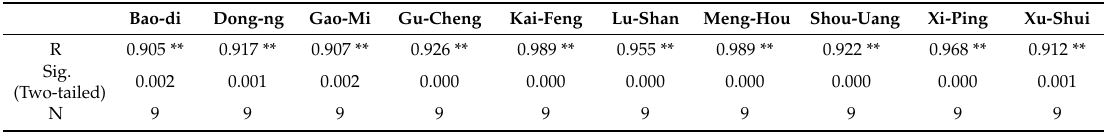
Table 4. Correlation analysis between the actual MODIS EVI curve and the simulation standard EVI curve of maize.